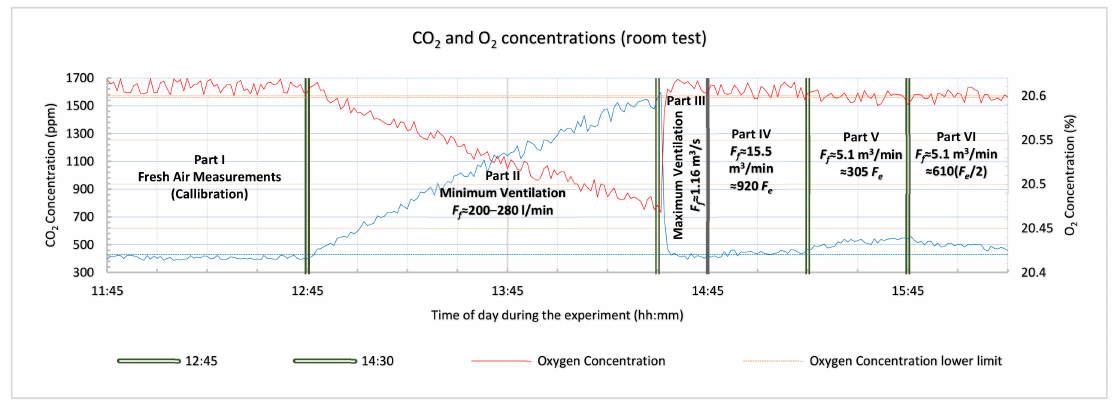
Figure 2. Room with two people test